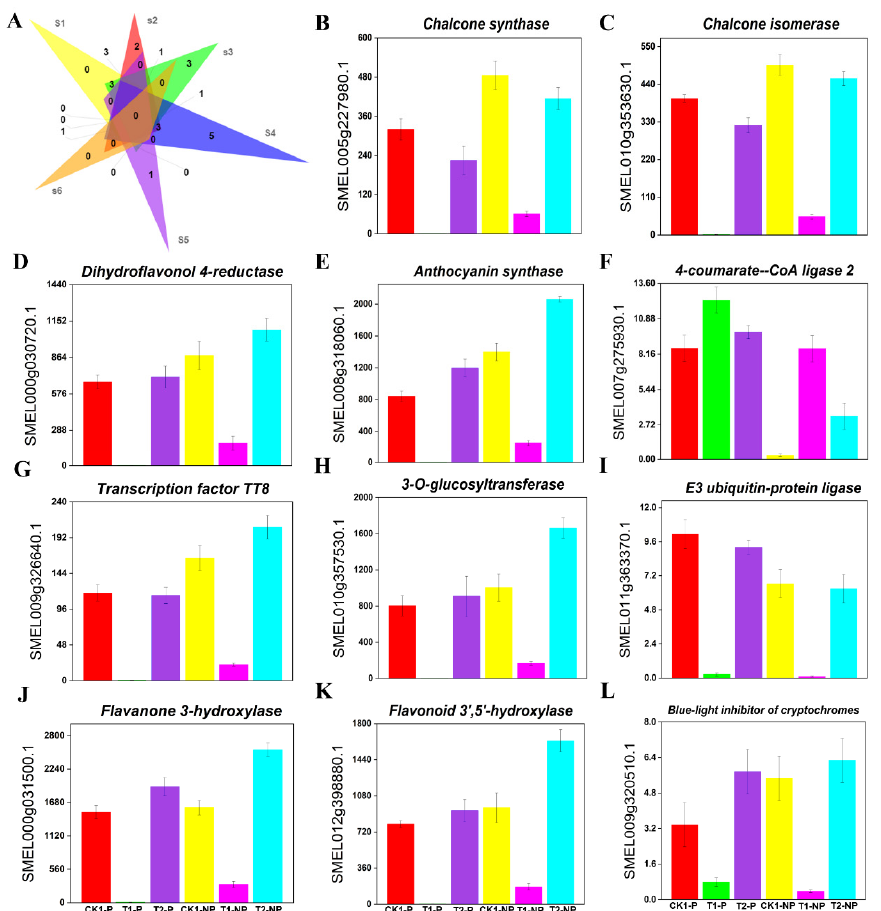
Figure 4. Effects of shading and light on gene expression and signal transduction related to eggplant peel color. ( A ) Venn diagram showing differentially expressed genes related to eggplant peel color in the six comparison groups (S1: CK1-P vs. T1-P; S2: T1-P vs. T2-P; S3: CK1-NP vs. T1-NP; S4: T1-NP vs. T2-NP; S5: T1-P vs. T1-NP; S6: T2-P vs. T2-NP); ( B ) Chalcone isomerase ( CHS ); ( C ) Chalcone isomerase ( CHI ); ( D ) Dihydroflavonol 4-reductase ( DFR ); ( E ) Anthocyanin synthase ( ANS ); ( F ) 4-Coumarate–CoA ligase 2 ( 4CL2 ); ( G ) Anthocyanin-related transcription factor TT8 ; ( H ) 3-O-glucosyltransferase ( 3GT ); ( I ) E3 ubiquitin-protein ligase ( COP1 ); ( J ) Flavanone 3-hydroxylase ( F3 ′ H ); ( K ) Flavonoid 3 ′ ,5 ′ -hydroxylase ( F3 ′ 5 ′ H ); and ( L ) Transcription factor MYB1 . (( B – L ): The X-axis represents different eggplant groups, and the Y-axis represents FPKM values); the error bar represents the degree of dispersion of the gene expression data itself, as follows.